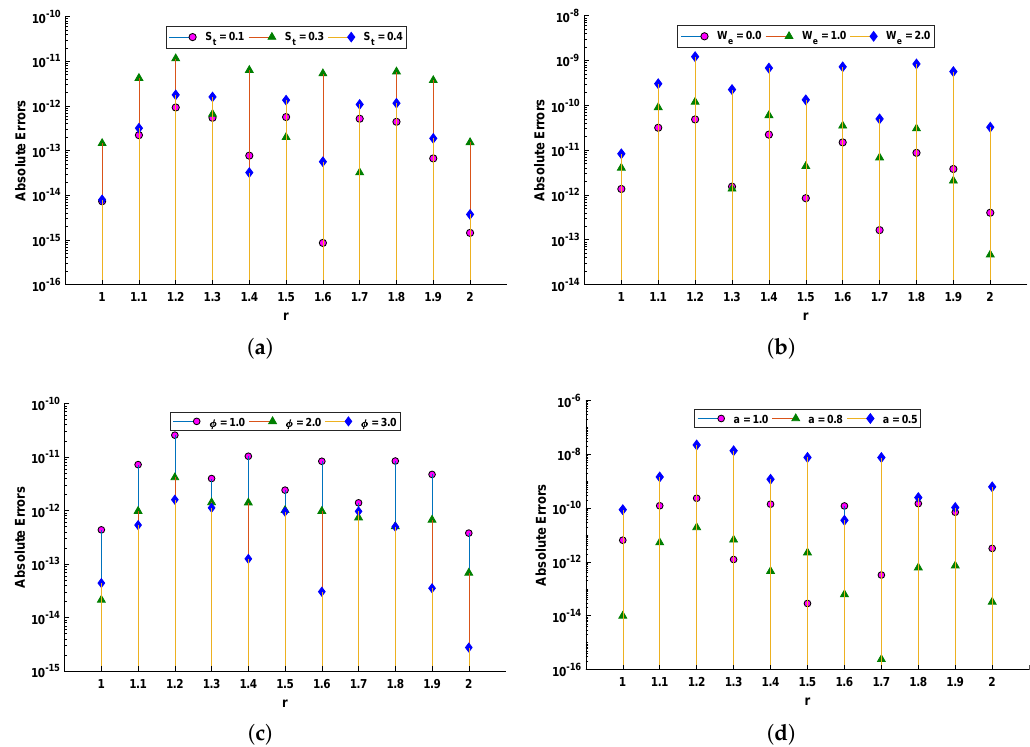
Figure 7. Absolute error in solutions calculated by the LNN-GNDO-SQP algorithm for different scenarios of drainage problem. ( a ) SCENARIO I. ( b ) SCENARIO II. ( c ) SCENARIO III. ( d ) SCENARIO